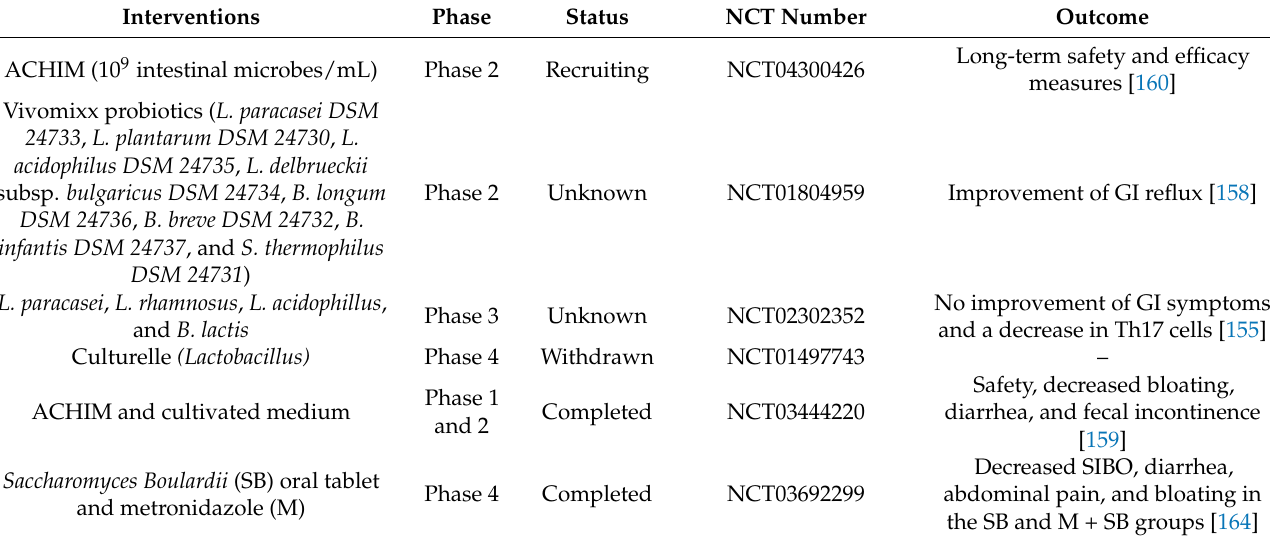
Table 1. Clinical trials to determine the efficacy of microbial therapeutics in SSc. Interventions Phase